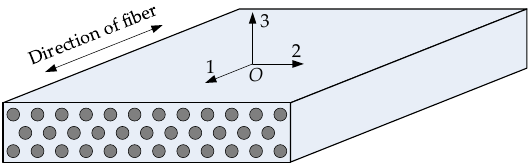
Figure 3. Schematic diagram of the unidirectional carbon-fiber-reinforced composite lamina.